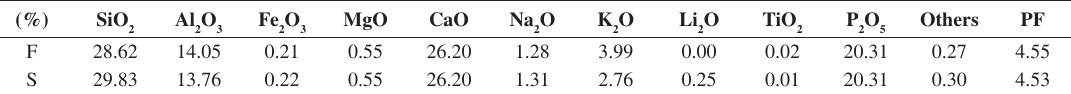
Table 5. Feldspar (F) and Spodumene (S) bodies in oxide composition. (%) SiO 2